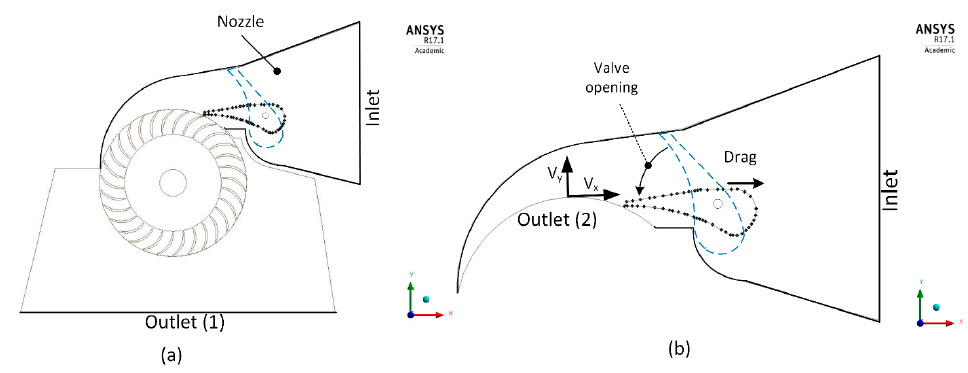
Figure 8. The nozzle region and boundaries of T15-300 cross-flow turbine model: ( a ) the full cross-flow turbine model and ( b ) separate nozzle region with both the inlet and outlet boundaries.